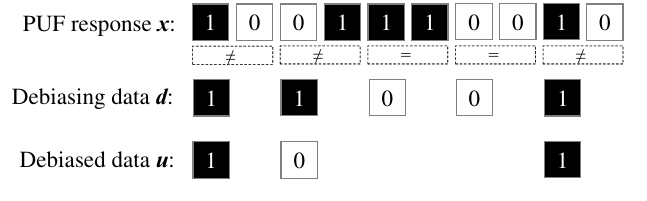
Figure 4: Example of VNC-based